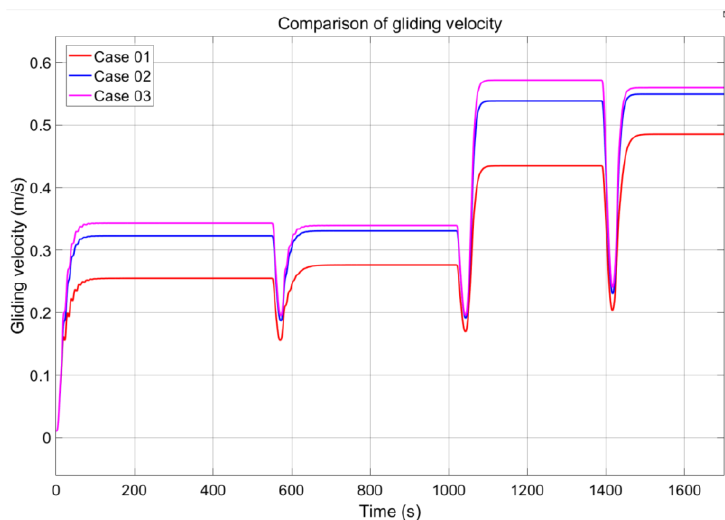
Figure 13. Comparison of gliding velocity.